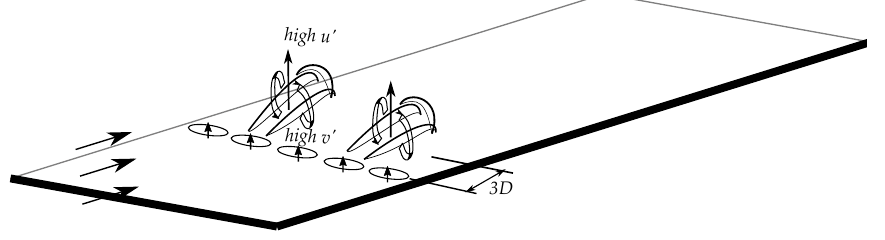
Figure 9. A schematic of hairpin vortices generated downstream of blowing. Wall-normal and streamwise velocity fluctuations are shown with respect to the vortex structure